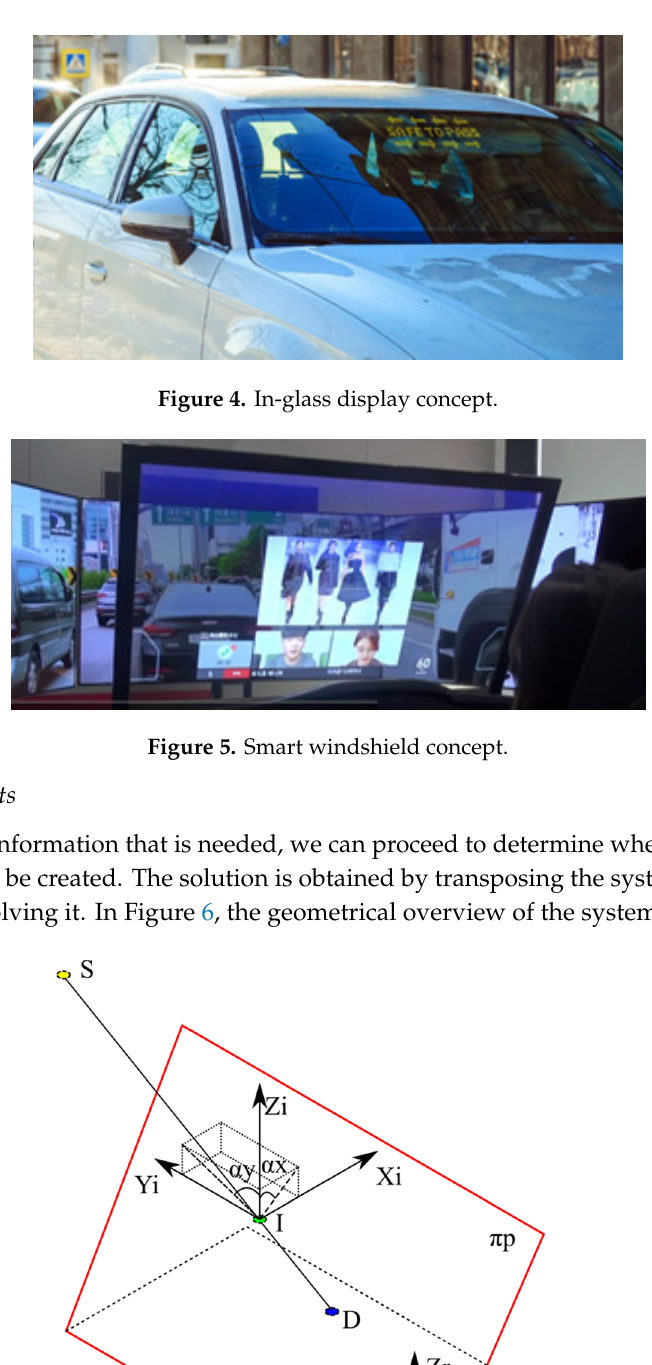
Figure 6. Geometrical overview of the system.